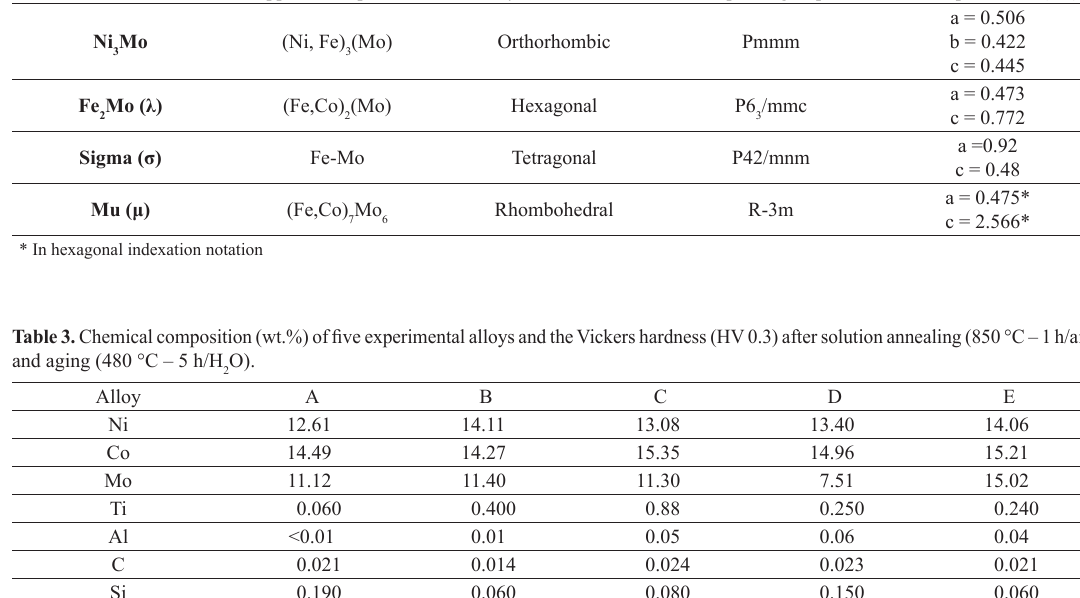
Table 2. Main intermetallic compounds that may occur in the Fe-13Ni-15Co-10Mo steel 23,40-42 . Phase Approx. composition